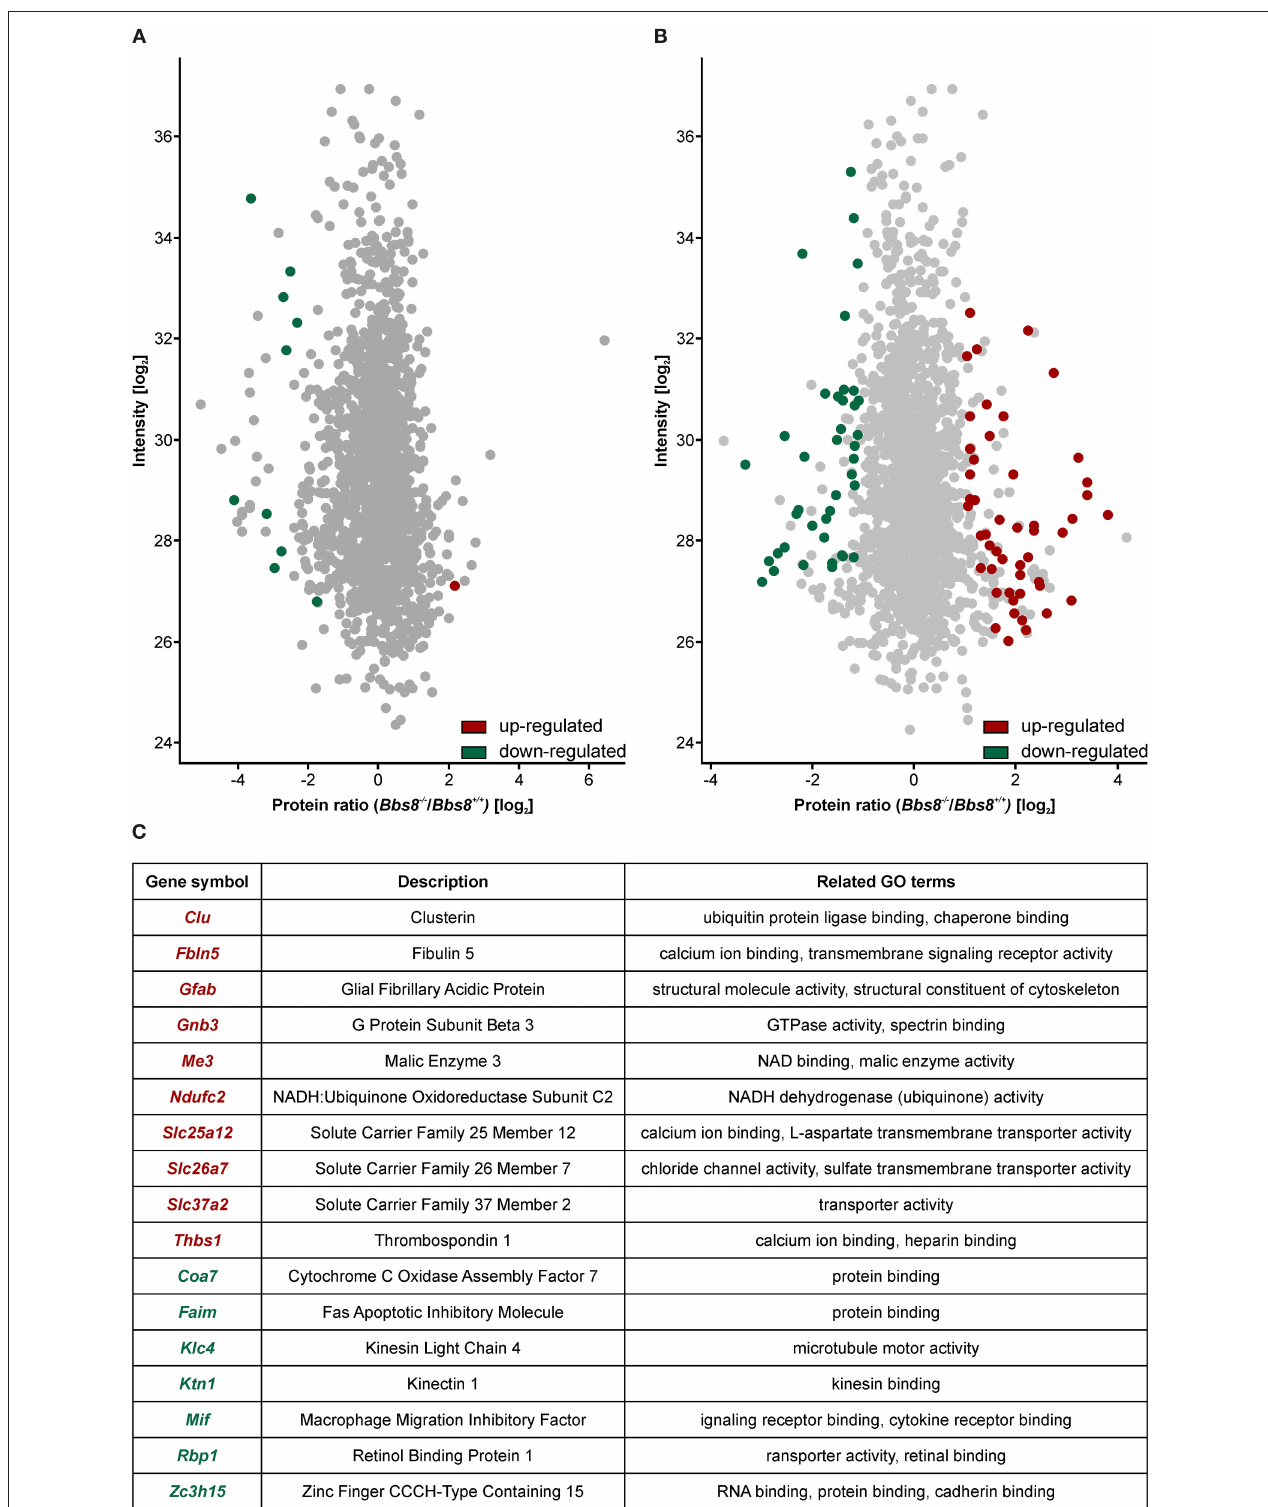
FIGURE 5 | Proteomic analysis shows an increase in mis-regulated proteins in P29 Bbs8 − / − RPE. (A) Volcano plot showing significantly up-regulated (red) and down-regulated (green) proteins in P11 Bbs8 − / − RPE compared to controls. (B) Volcano plot showing significantly up-regulated (red) and down-regulated (green) proteins in P11 Bbs8 − / − RPE compared to controls. (C) Comparison of Proteome and Transcriptome data. Chart shows commonly up or down-regulated molecules at P29 with gene symbols, descriptions and related GO terms.